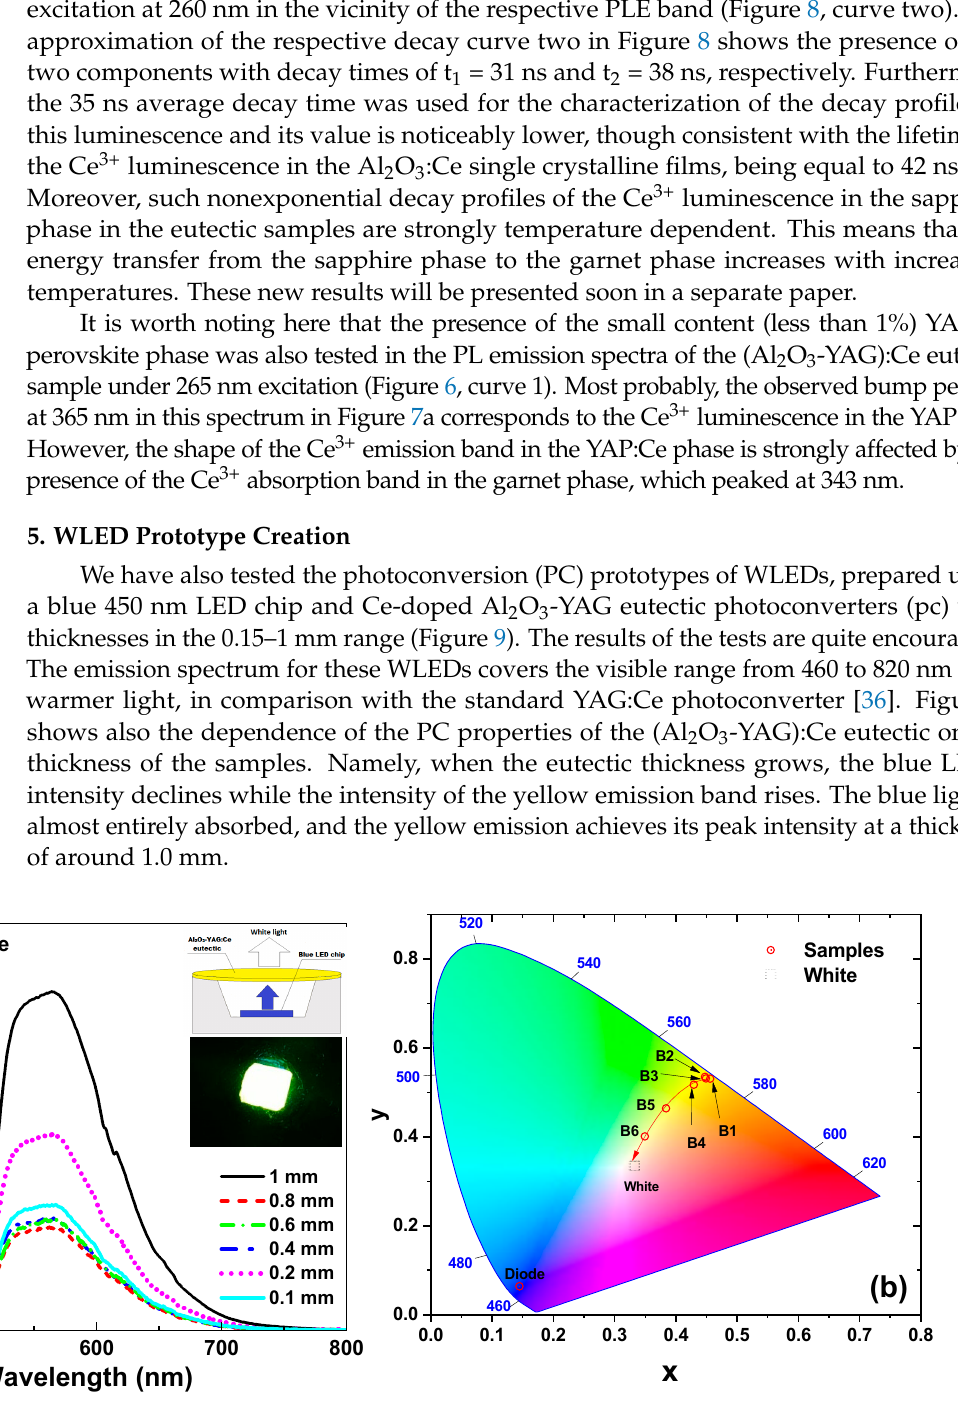
Figure 9. The spectral performance of (Al 2 O 3 -YAG):Ce eutectic samples under 450 nm blue LED excitation ( a ); color coordinates of (Al 2 O 3 -YAG):Ce eutectic based LEDs in CIE-1931 color space chromaticity diagram ( b ).